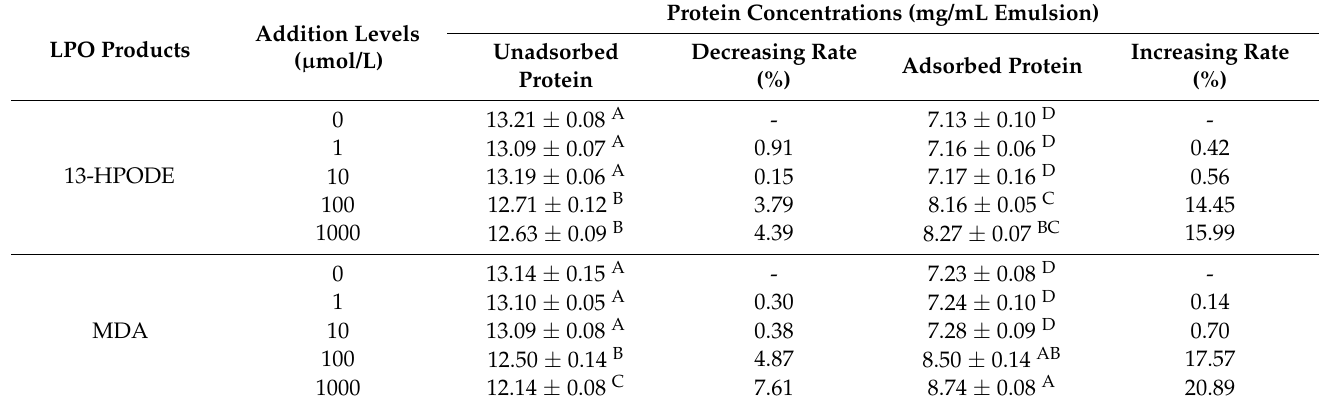
Table 1. Protein concentrations of unadsorbed and adsorbed proteins extracted from the oil-in-water (O/W) emulsion oxidized by different levels of 13-hydroperoxide (13-HPODE) or malondialdehyde (MDA) for 24 h. Protein Concentrations (mg/mL Addition Levels LPO Products ( µ mol/L)